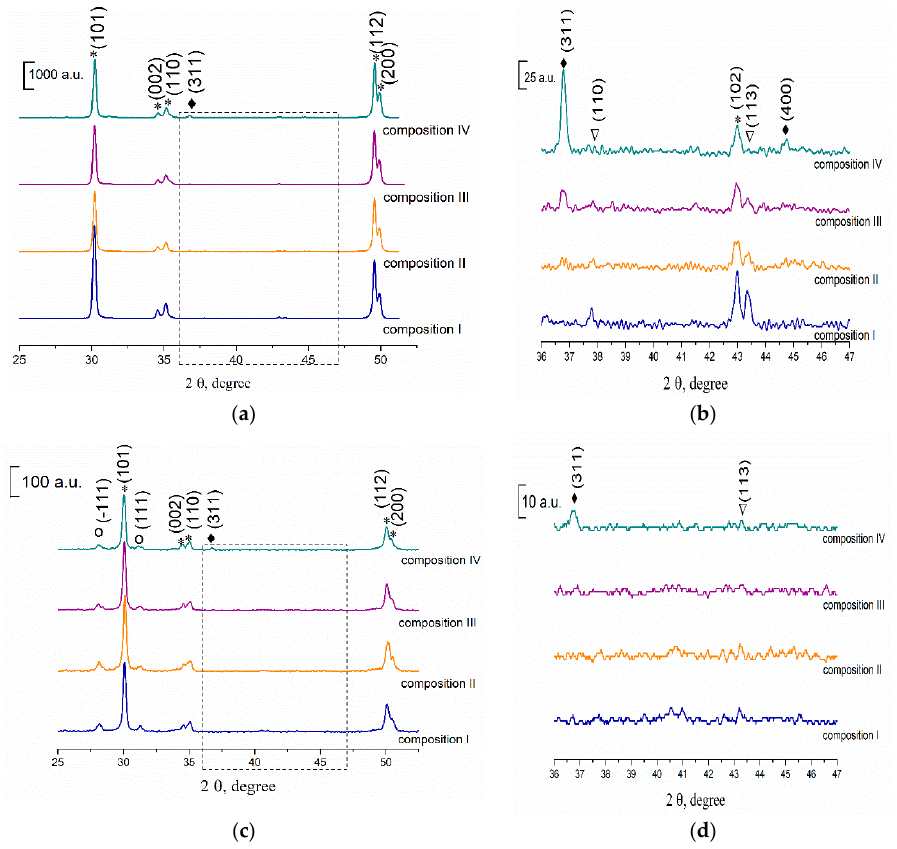
Figure 4. XRD spectra of 3Y-TZP-Al 2 O 3 ceramics sintered at: ( a , b ) 1350; ( c , d ) 1450 °C, where *—t-ZrO 2 , o—m-ZrO 2 , ∇ —Al 2 O 3 , ♦ —CoAl 2 O 4 .